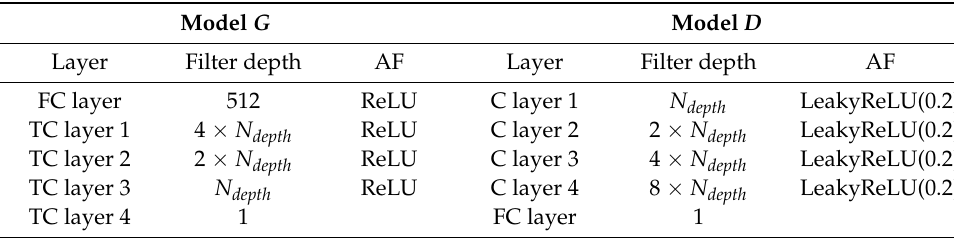
Table 1. Architecture details of model G and model D .